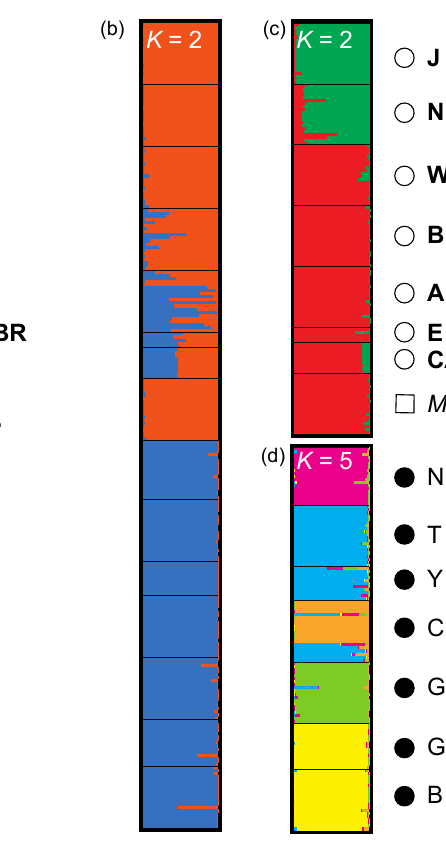
Figure 3. The genetic structure of sampled populations of Banksia nivea in south-western Australia, based on individual nuclear microsatellite genotypes. ( a ) A neighbor-joining (NJ) tree of CS Chord distance. Support is shown on the branches as the number of bootstraps out of 1000. Values > 500 are shown. ( b – d ) Bar graphs inferred using Bayesian assignment in S TRUCTURE 2.3.4 showing ( b ) structure at K = 2 for all subspecies ( c ) structure at K = 2 for subspecies nivea and Morangup, and ( d ) structure at K = 5 for subspecies uliginosa . Each individual is represented as a single line with colored segments representing the proportion of ancestry from k clusters ( q ). Results are the optimal alignment of replicates.